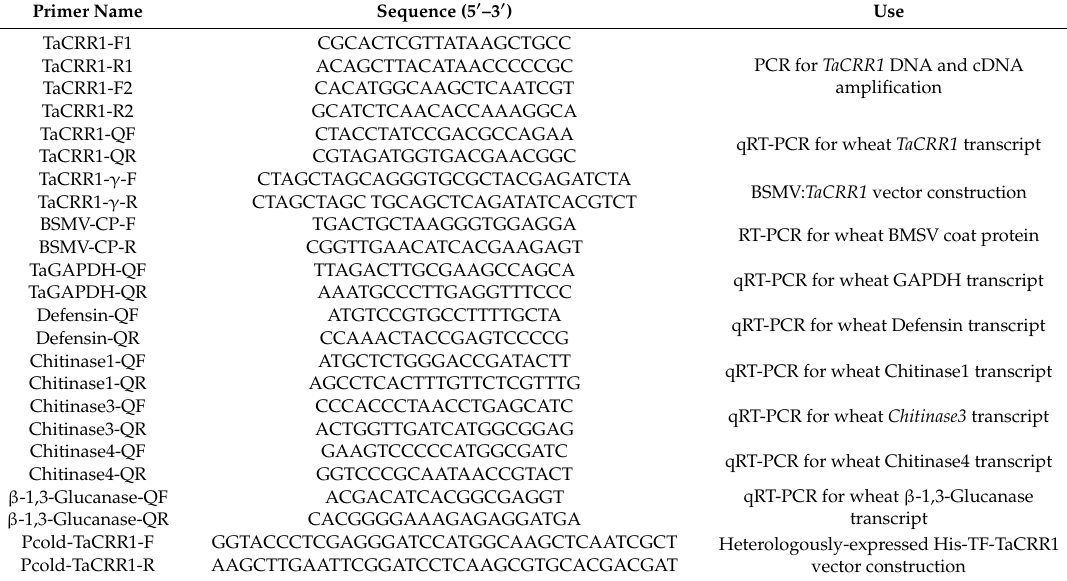
Table 1. Primers and their sequences in this